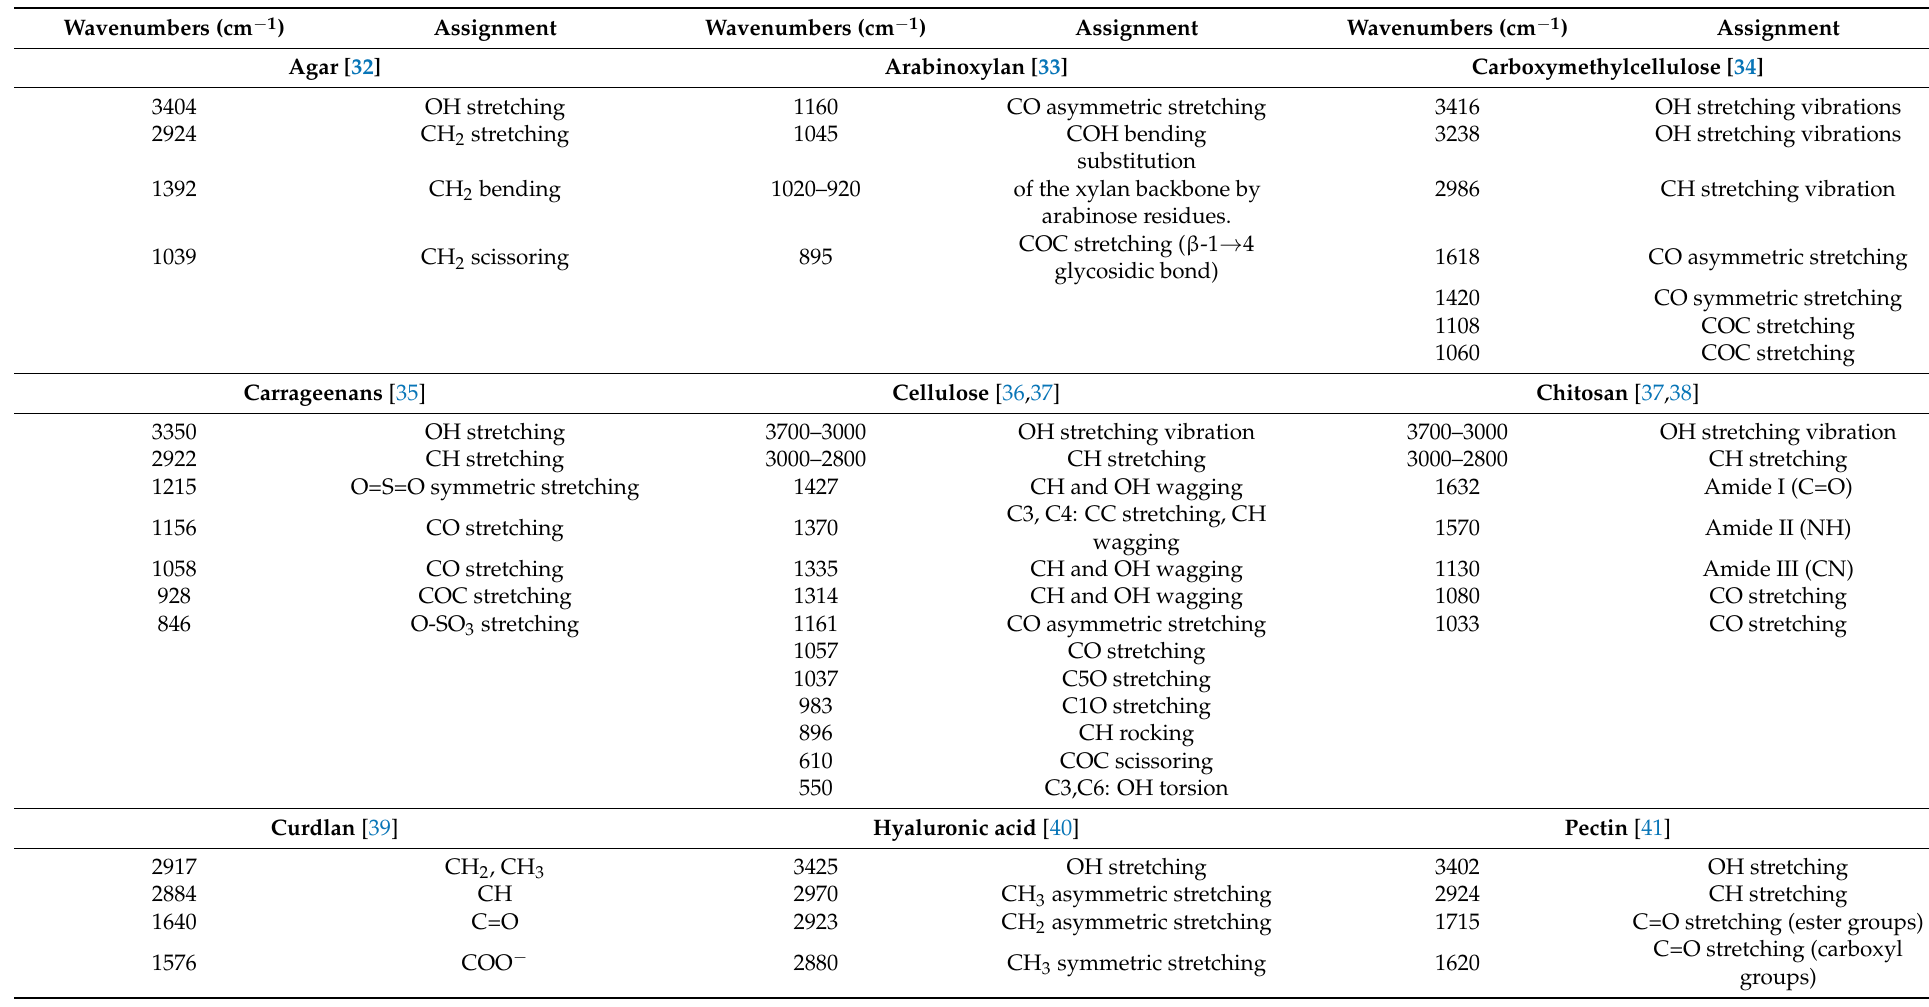
Table 1. The most important bands obtained in the FTIR spectra of described